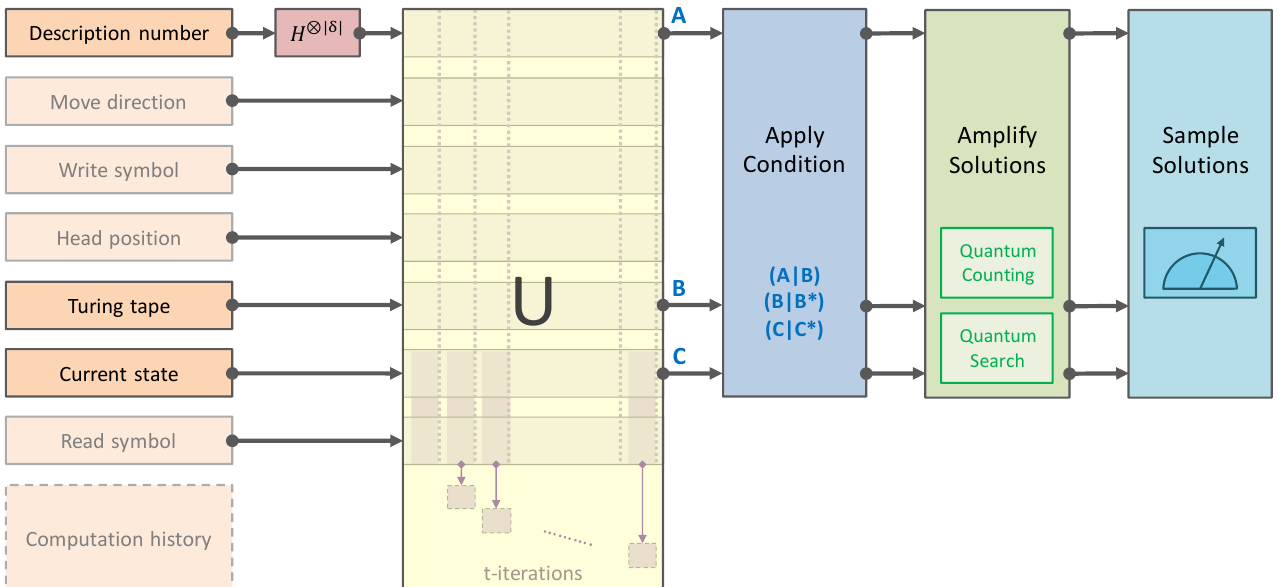
Figure 11. Application development framework for quantum experimental algorithmic information